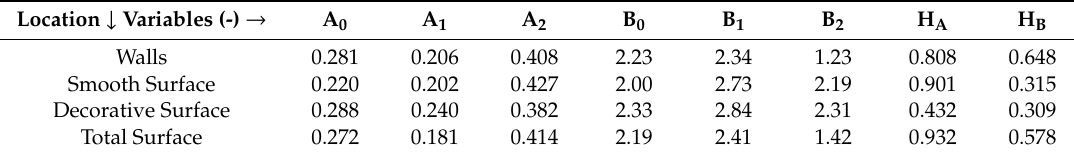
Table 7. Spatial variation of catalyst-support ratios (A n n = 0, 1, 2) and catalyst lattice oxygen-supported catalyst molar ratios (B n n = 0, 1, 2) together with the corresponding heterogeneity indices H A and H B at various locations for the catalyst Co / Si = 1 / 4.